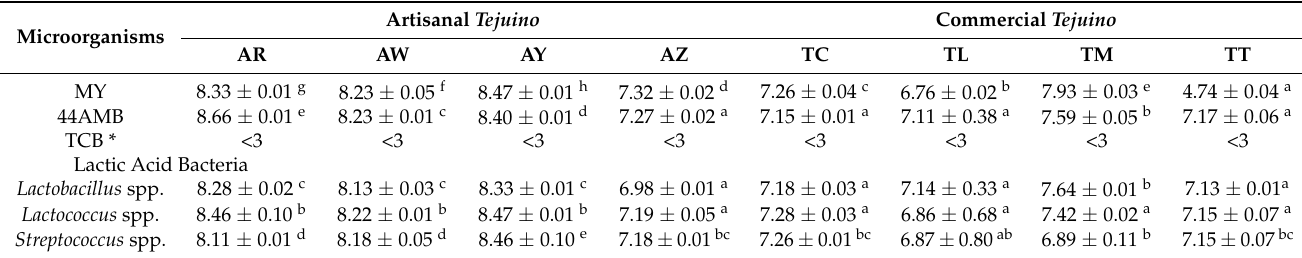
Table 2. Microbiological quality of artisanal and commercial Tejuino beverages from Nayarit, Mexico. Artisanal Tejuino Commercial Tejuino